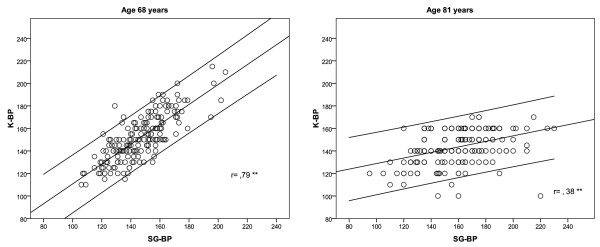
Correlation between Strain Gauge (SG-BP) and Korotkoff blood pressure (K-BP) measurement in the same subjects at age 68 and at age 81. Regression line with 95% confidence intervals.